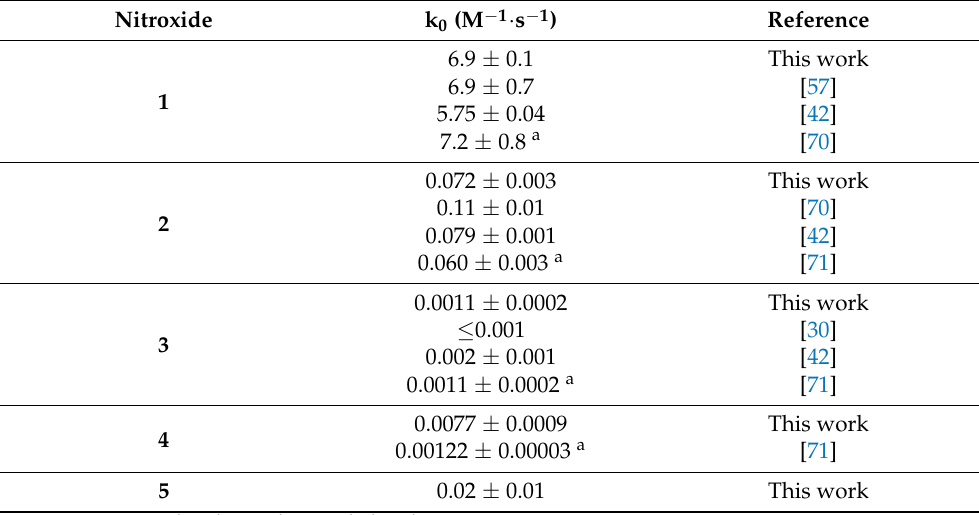
Table 1. Initial second-order reaction rate constants (M − 1 · s − 1 ) for the reduction of a series of nitroxides (Figure 1) by excess